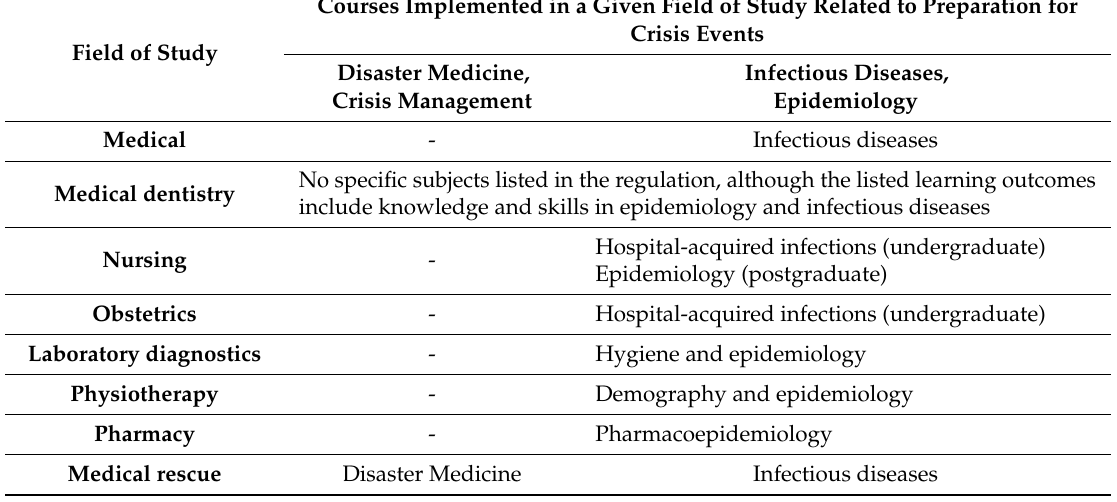
Table 1. The 2019 educational standard for medical